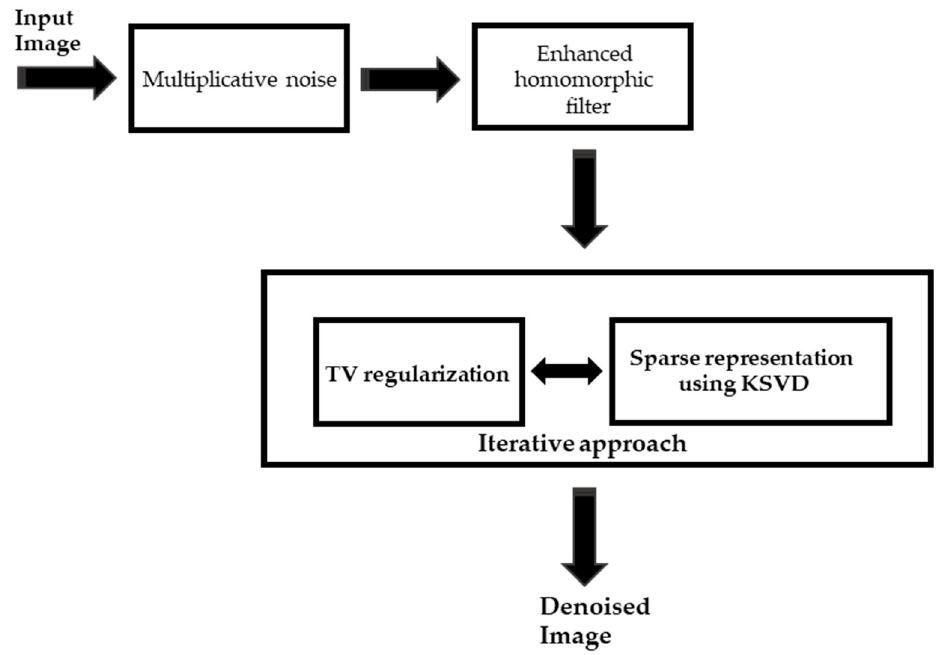
Figure 3. Proposed despeckle model for an ultrasound image. KSVD: K-singular value decomposition.